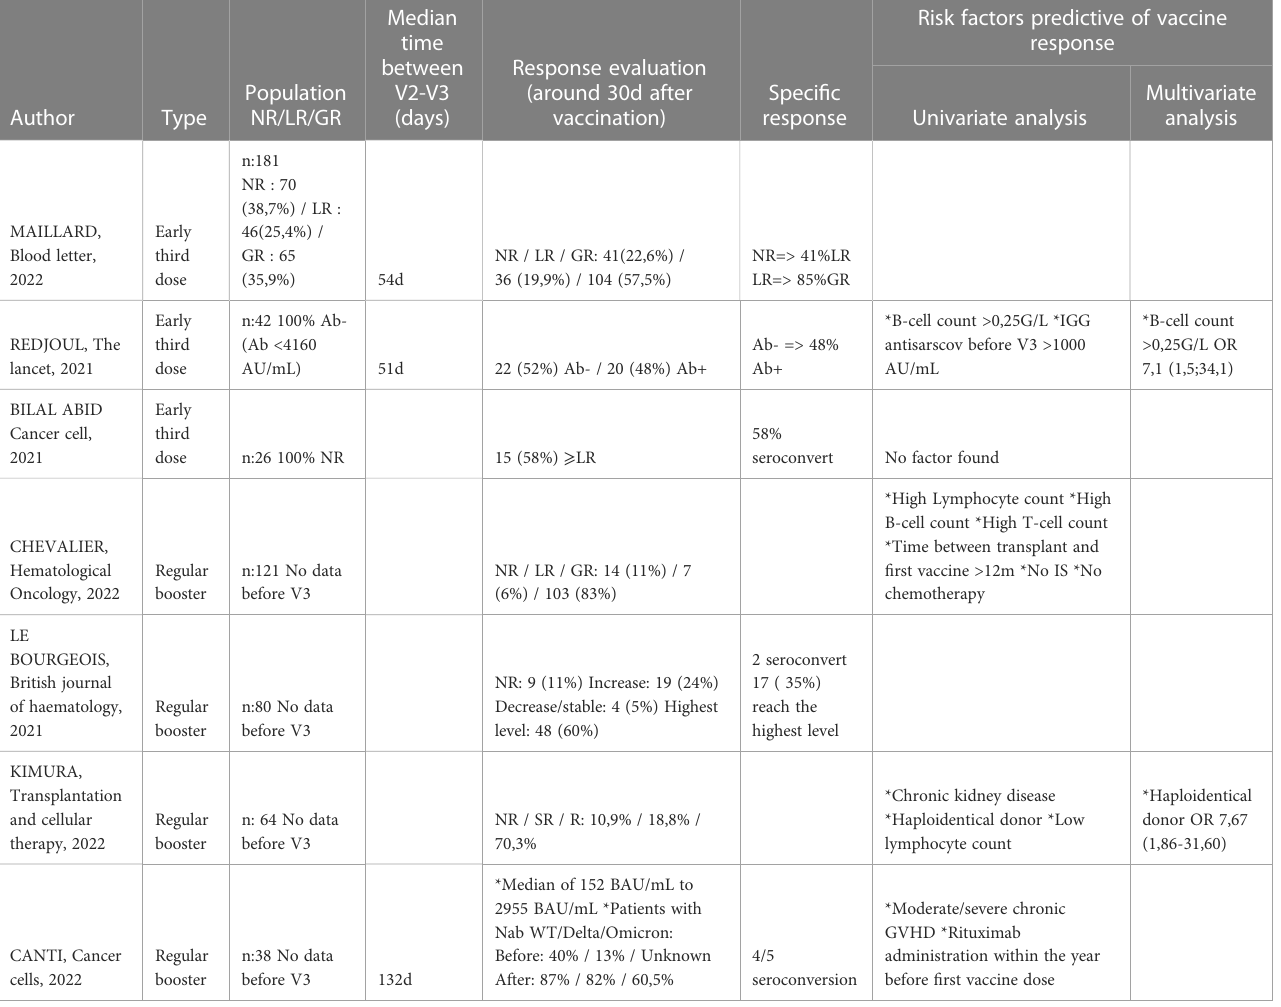
TABLE 3 Impact of third dose in allo-HSCT patients.